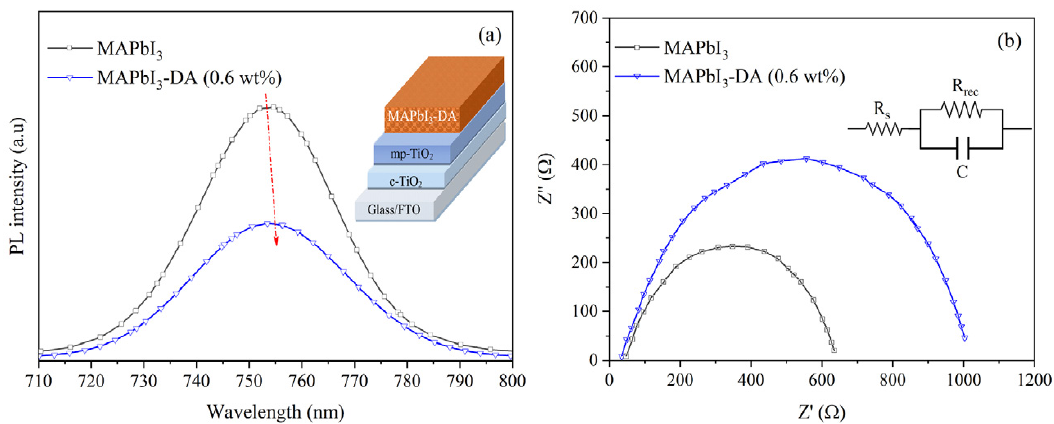
Fig. 6. (a) Steady-state PL spectra of MAPbI 3 without or with 0.6 wt% DA. Inset: The photoanode composed of MAPbI 3 /ETL layers. (b) Nyquist plots of the PSCs without or with 0.6 wt% DA. Inset: The equivalent circuit model for fitting the plots.